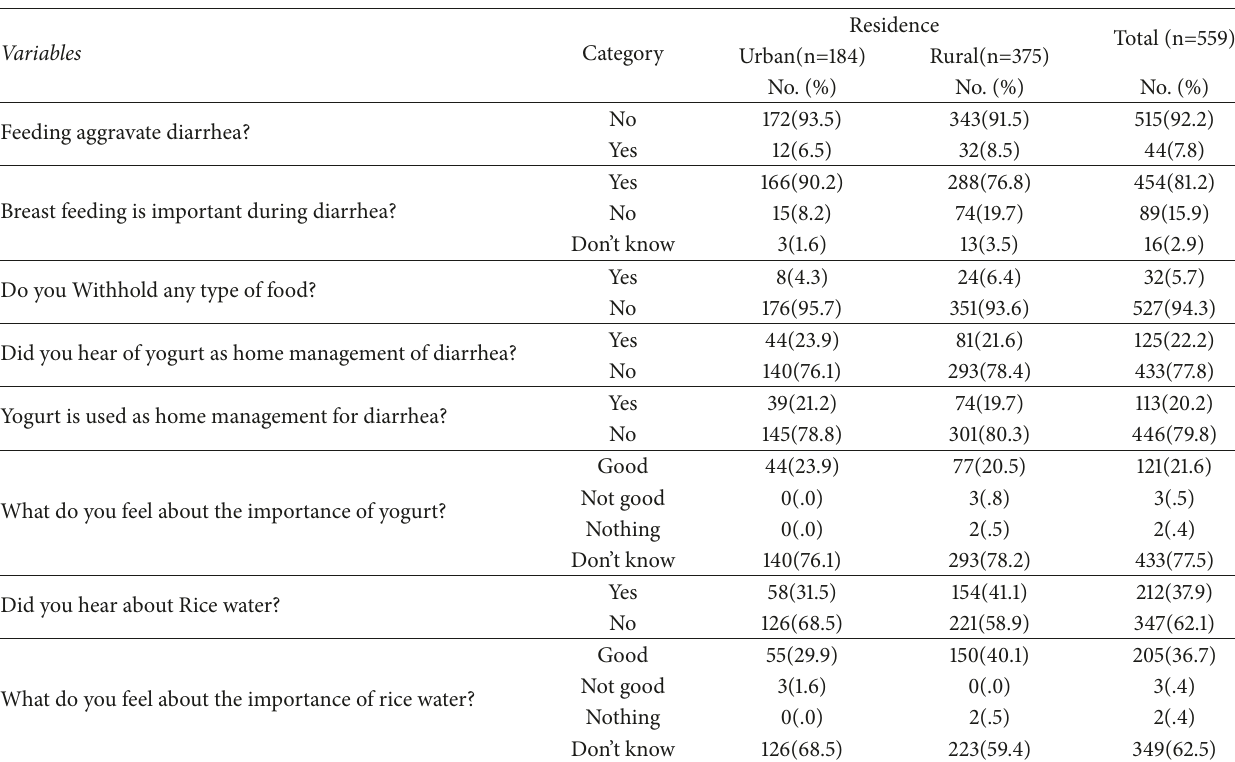
Table 3: Knowledge and attitude of feeding practice among caregivers of under-five children’s in urban and rural resident of Doba woreda, Ethiopia.